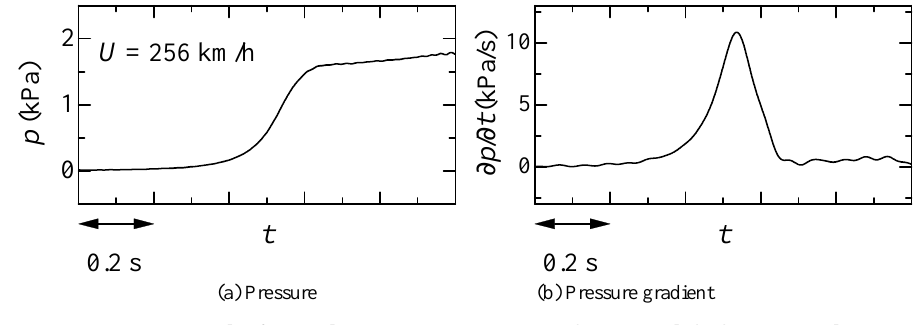
Fig. 1 Example of a tunnel compression wave measured at an actual Shinkansen tunnel entrance. is the tunnel diameter. In the case of the Japanese Shinkansen, L nose ∼ 10 m, d / 2 ∼ 6 m and λ ∼ 50